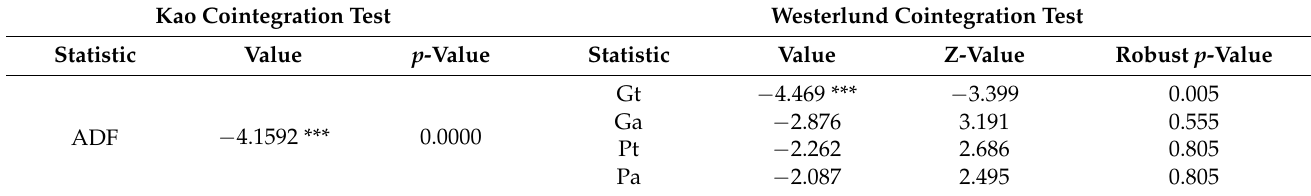
Table 5. The Results of Panel Cointegration